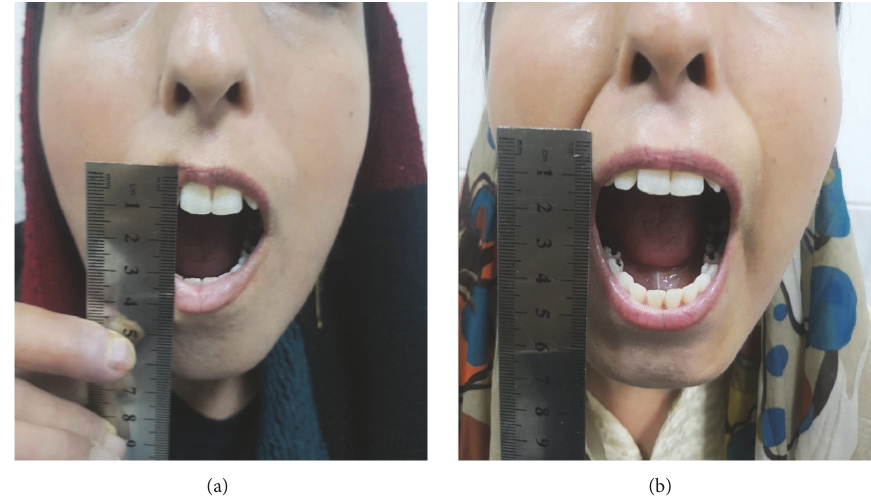
Figure 2: Mouth opening capacity at baseline (a) and significant improvement in mouth opening capacity 3 months after autologous fat transfer